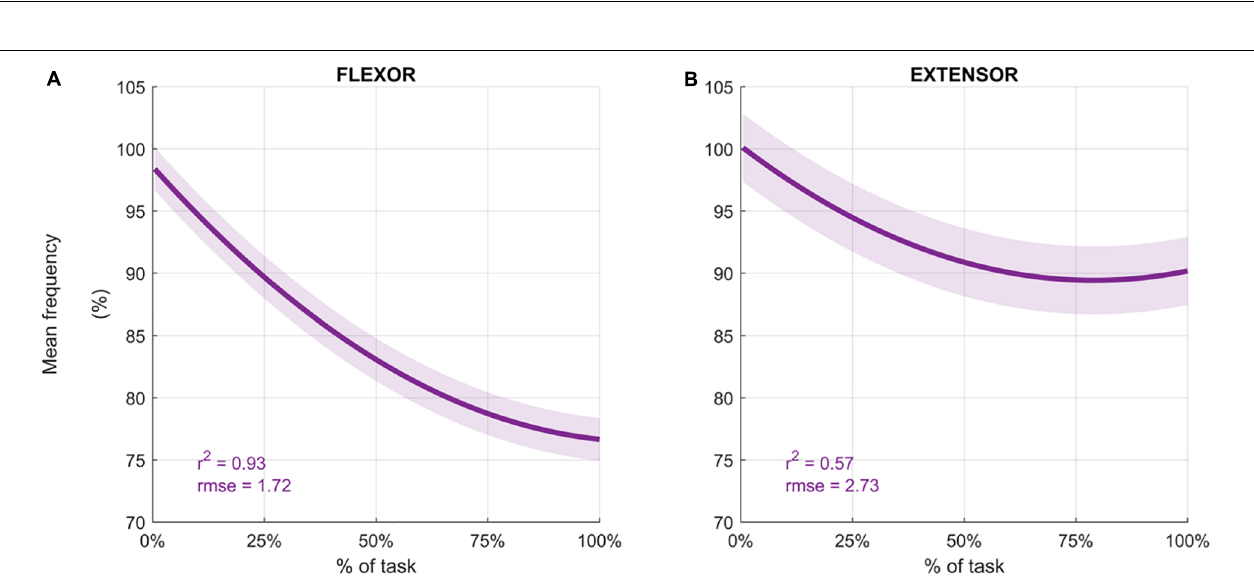
FIGURE 4 | Average mean frequency values (%) for the flexor carpi radialis (A) and extensor carpi radialis muscles (B) during the fatigue protocol. Mean frequency (Hz) was normalized to the initial frequency of each sequence and averaged across participants to obtain the percentage. Depicted data was fitted with a second order polynomial function (dark purple) and standard error (light